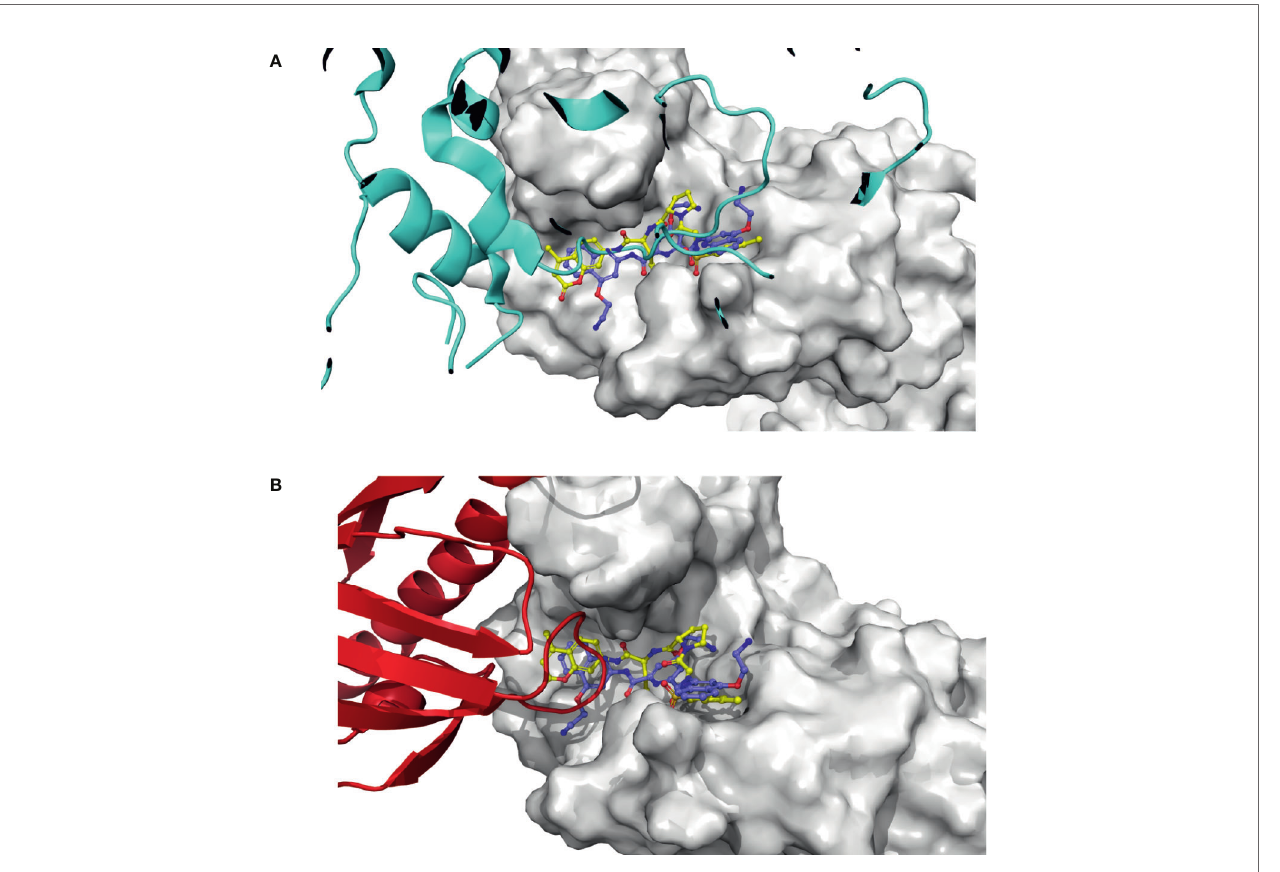
FIGURE 7 | PYL1 and SnRK2.6 interaction loops, and docking pose structural correlation. (A) SnRK2.6 is shown as a blue cartoon, docked molecules are shown as sticks, and PP2C is shown as a surface. (B) The PYL1 receptor is shown as a red cartoon, docked molecules are shown as sticks, and PP2C is shown as a